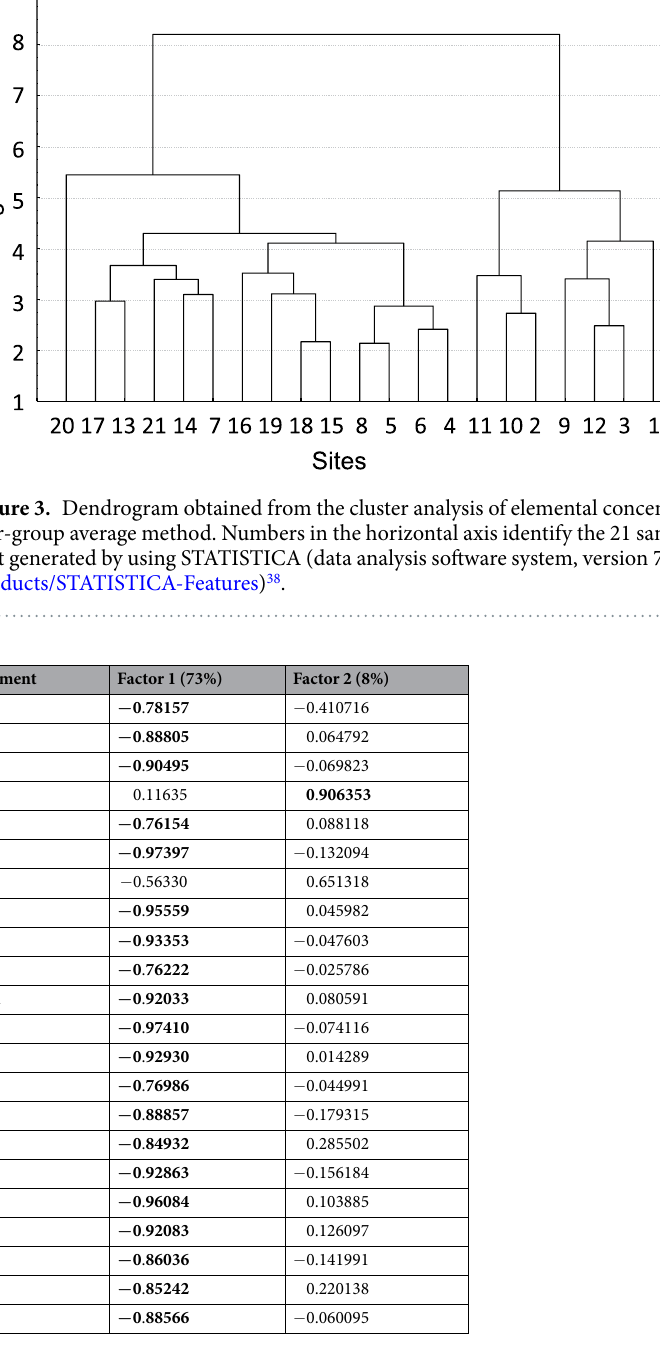
Table 4. Principal factors obtained after a varimax rotation. The percentages of each factor are shown in parentheses. Two factors explain 81% of the total